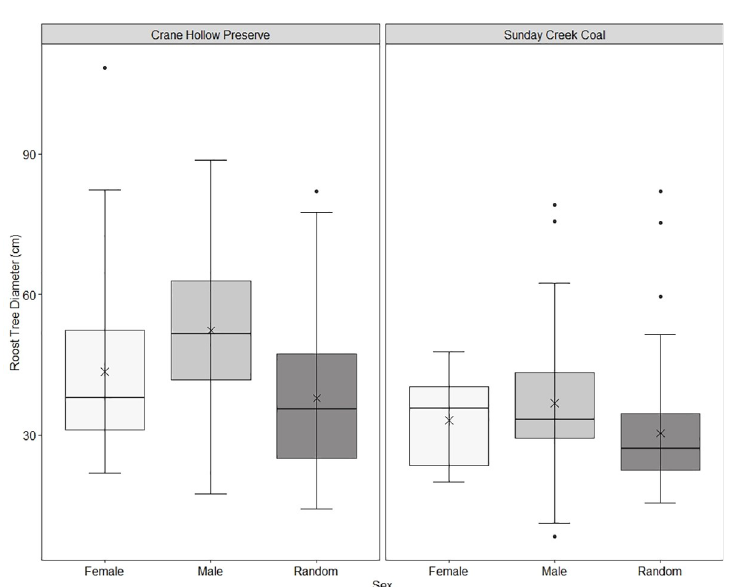
Fig 3. Box and whisker plot showing roost tree diameter of male (light grey) and female (white) eastern red bats at Crane Hollow Preserve and Sunday Creek Coal study areas in southeast Ohio, 2016–2019. Males roosted in larger diameter trees while the diameter of female roosts was similar to that of randomly sampled trees. Medians are depicted by the solid line, means are represented by the X’s, and outliers are depicted as black dots. Quartiles 2 and 3 are represented by the box and quartiles 1 and 4 are represented by